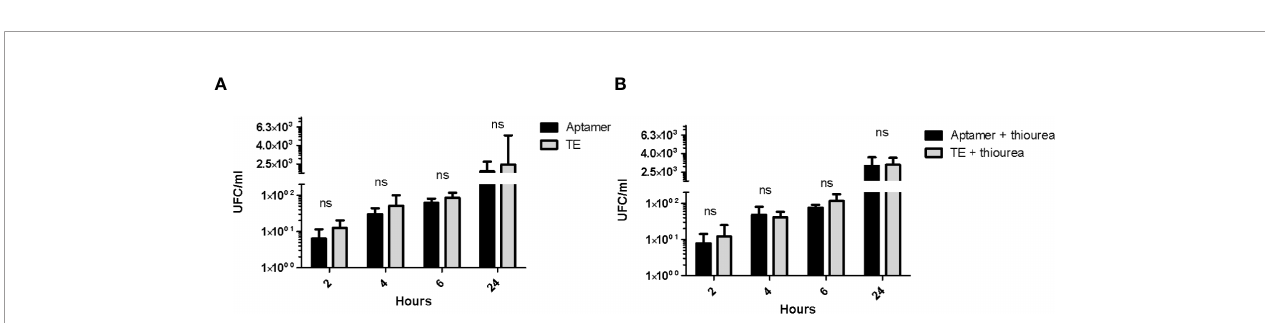
FIGURE 5 | Fluorescence microscopy for A01 aptamer with A. baumannii and K. pneumoniae cells. (A) A01 incubated with to A. baumannii cells. (B) A01 incubated with K. pneumoniae cells. (C) cells without aptamer. On the top: Confocal microscopy from two different points on the slide. Bottom: Fluorescence microscopy.